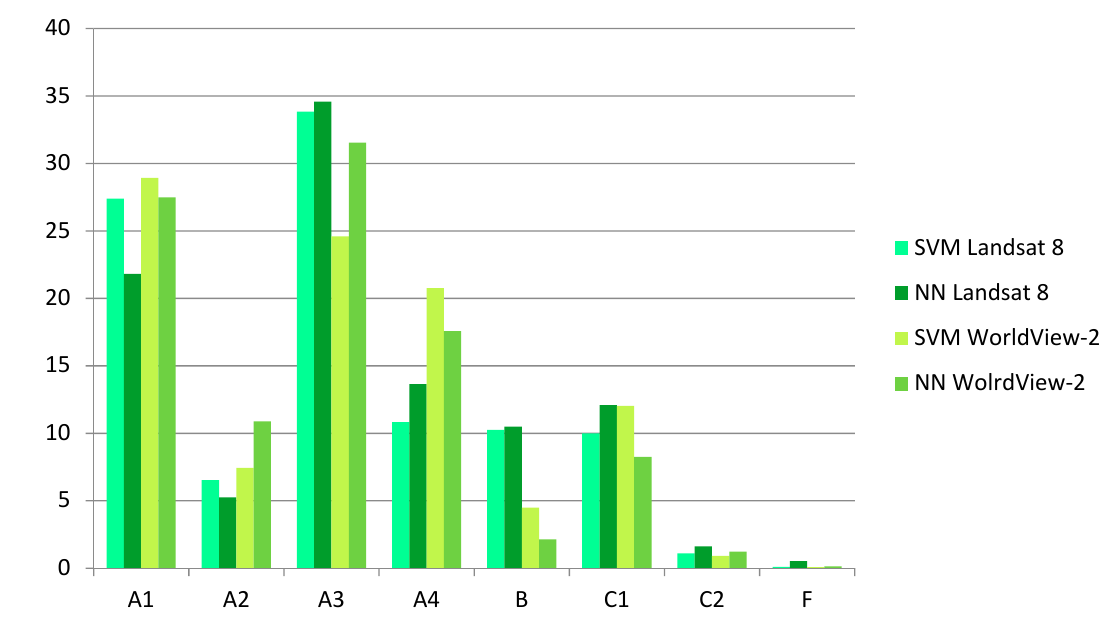
Figure 2. Relative representations of classes in SVM and NN classifications.